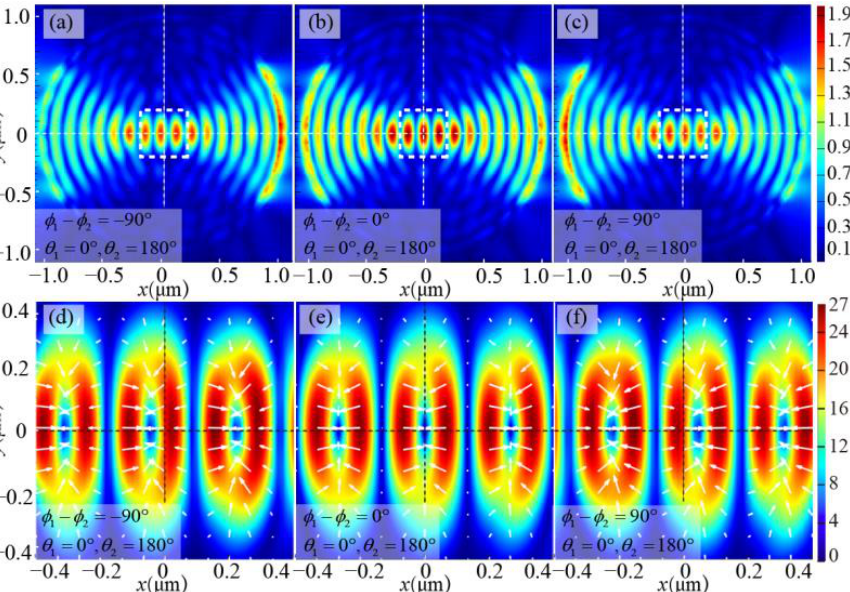
Figure 2. Different electric field ( a – c ) and optical force ( d – f ) distributions when changing the phase difference of the incident beams.